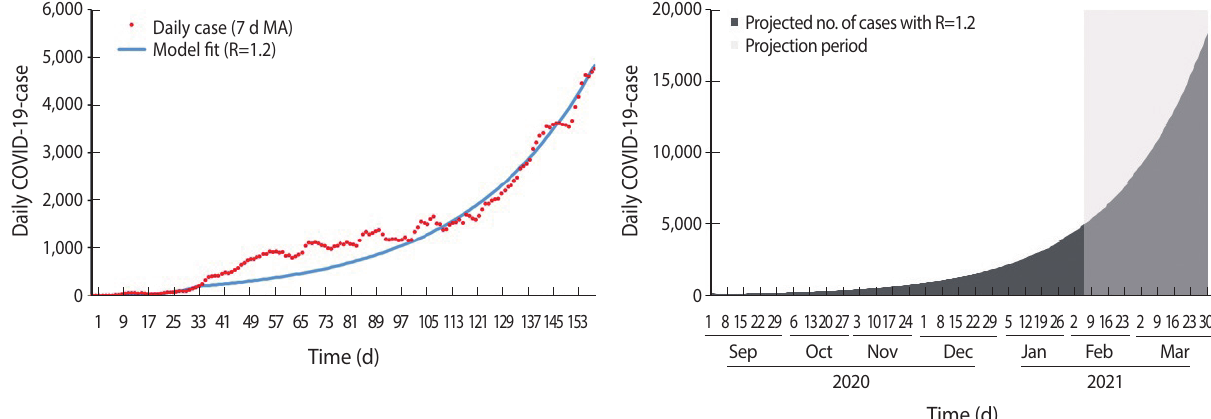
Figure 3. SEIR model fit and forecast for nationwide MCO. SEIR, susceptible-ex posed-infected-recovered; MCO, movement control order; COVID-19, coronavirus disease 2019; MA, moving